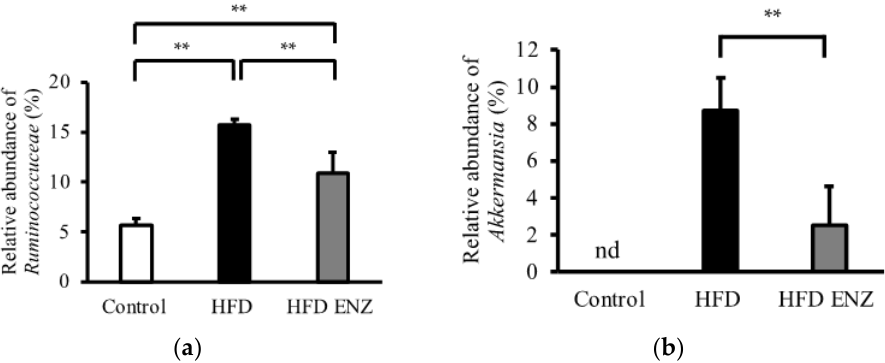
Figure 2. Relative abundance of Ruminococcuceae (family level) and Akkermansia (genus level). ( a ) Relative abundance of part of Ruminococcuceae family was compared between control mice (control), mice fed with high-fat diet (HFD), and Enzamin-treated mice fed with high-fat diet (HFD ENZ). ( b ) Relative abundance of part of Akkermansia genus was compared between control, HFD, and HFD ENZ. nd, not detectable. Data are shown as mean ± SD, n = 5, ** p < 0.01.